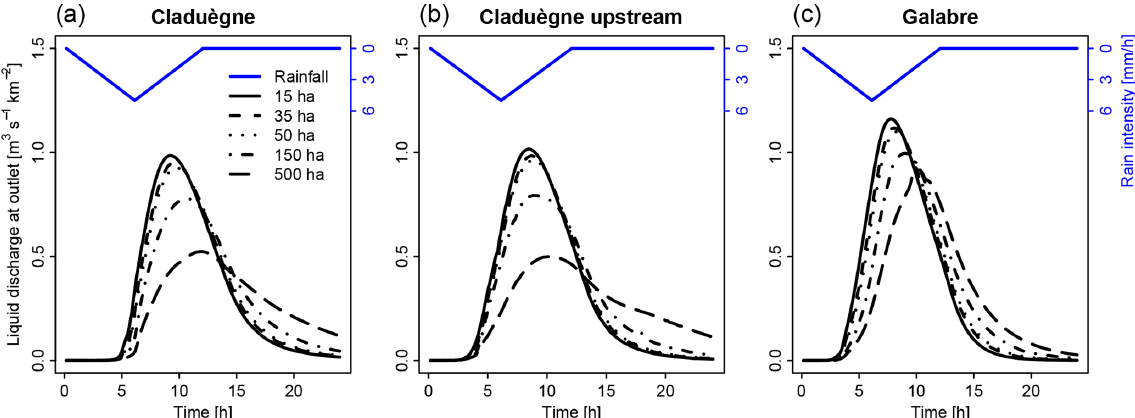
Figure 4. Simulated specific discharge obtained with different scenarios of model discretization at the outlet of (a) the 42km 2 Claduègne catchment and (b) the 20km 2 upstream outlet of the Claduègne where the size of the subcatchment is the same as that of (c) the Galabre catchment. The threshold for defining the river network is varied from 15 to